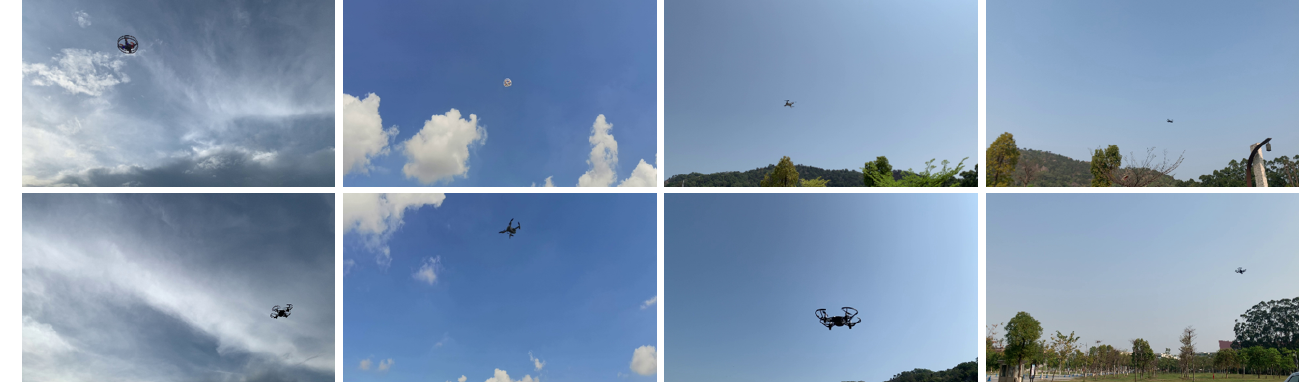
Figure 5. Part of the dataset for the anomaly identification